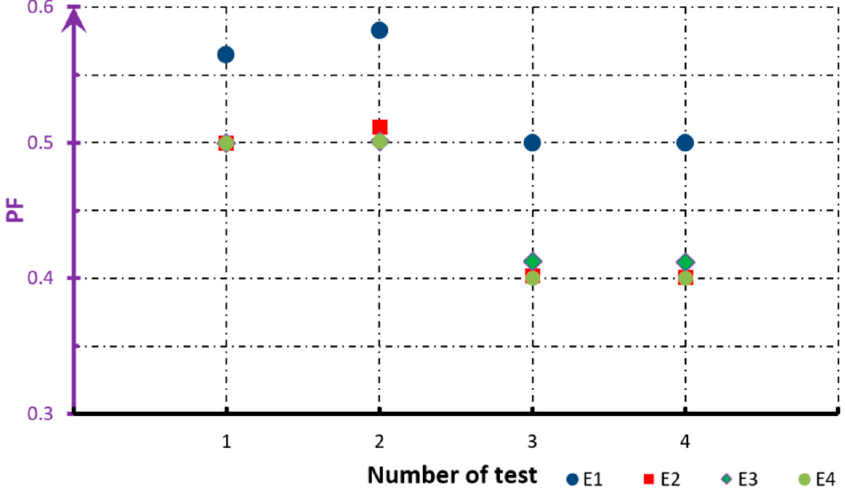
Figure 6. Chart of the power factor (PF) change for the tests. Measurement results of average temperature increments ( ∆ T AV ) are presented in Table 7. According to assumptions, tested LED sources are less sensitive to changes in harmonic content in the supply voltage, as they are not equipped with magnetic